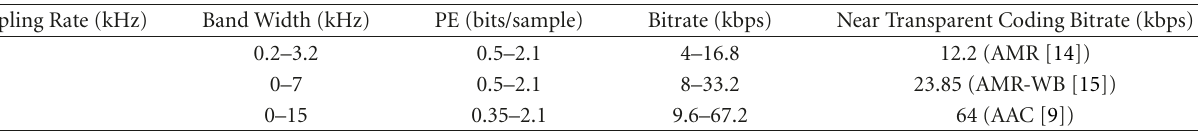
Table 1: PE and bitrate of various mono audio signals [13].